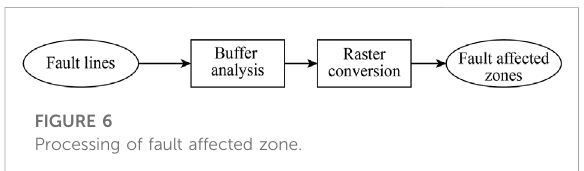
FIGURE 6 Processing of fault affected zone.